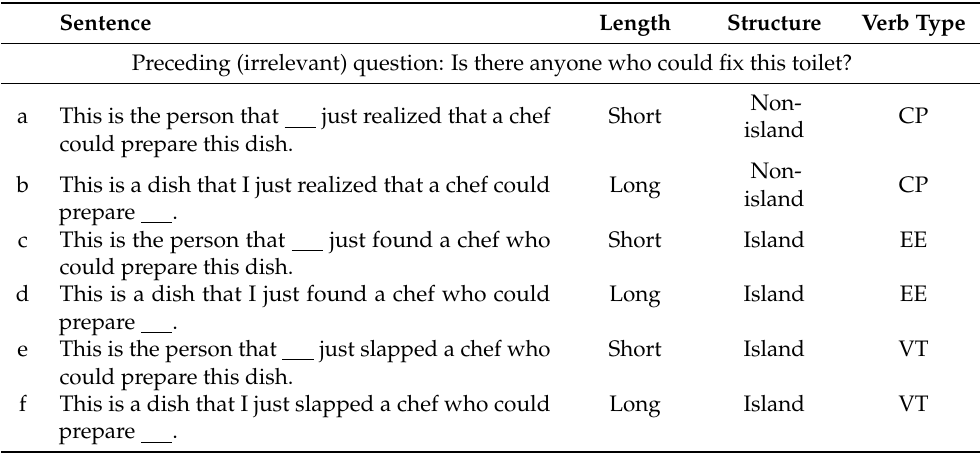
Table 5. Experiment 3 sample